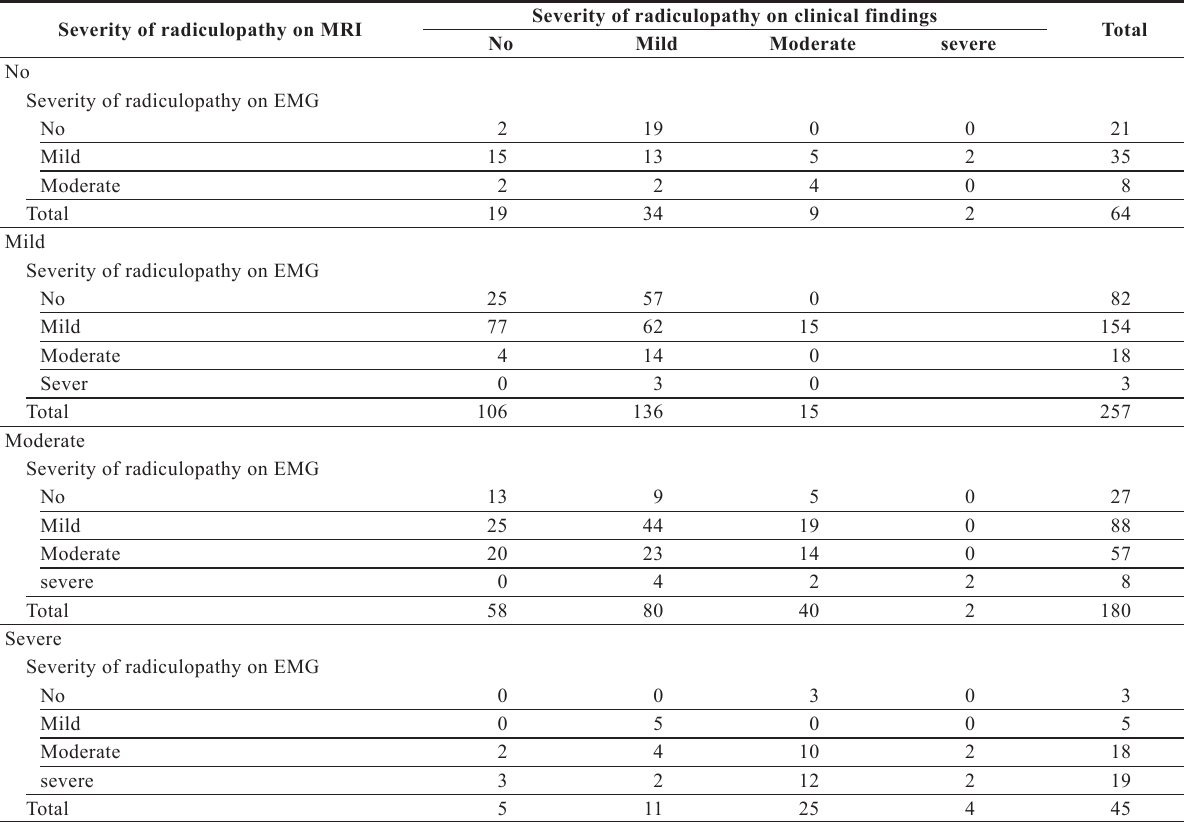
Table 3. The frequency distribution of severity of radiculopathy based on EMG and MRI and clinical findings.